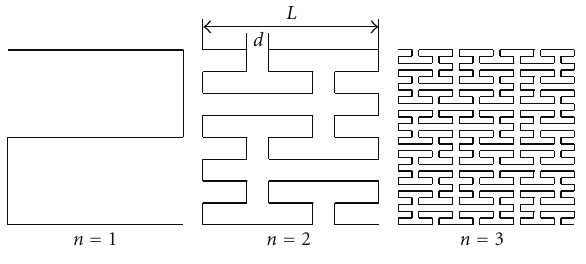
Figure 1: Peano curves from the first to the third